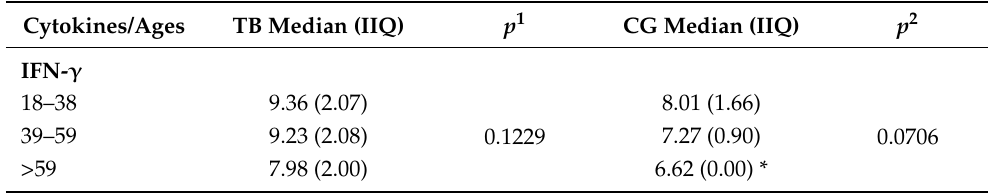
Figure 2. Comparison of: ( A ) IFN- γ ; ( B ) TNF- α ; ( C ) IL-6; ( D ) IL-2; ( E ) IL-4; ( F ) IL-10; and ( G ) IL-17 levels between the pulmonary tuberculosis (PTB) and extrapulmonary tuberculosis (EPTB) groups. Mann–Whitney test. Table 3. Comparison of cytokine levels according to the age group of patients with TB and individuals in the control